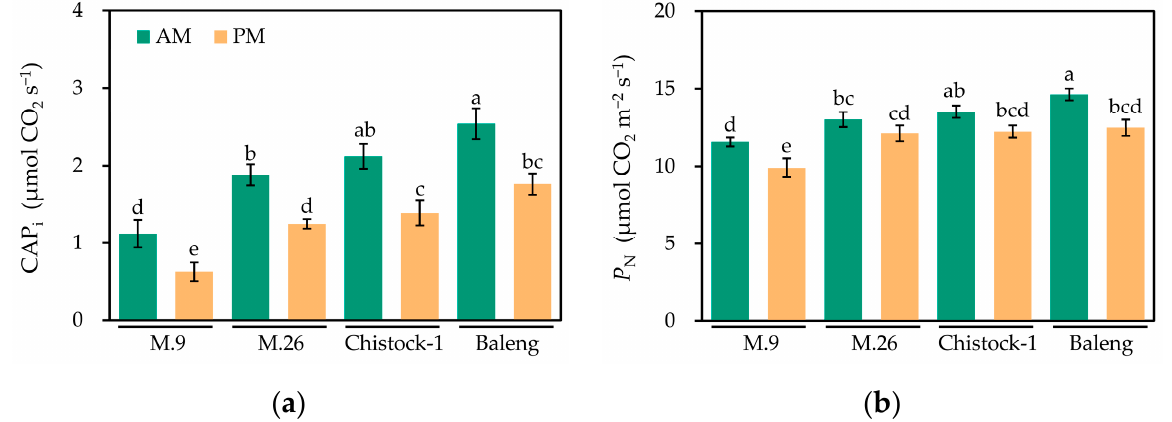
Figure 5. Instantaneous photosynthesis parameters of ‘Red Fuji’ scion leaf influenced by rootstocks in the morning (AM) and afternoon (PM). ( a ) Canopy-apparent photosynthesis (CAP i ); ( b ) leaf net photosynthetic rate ( P N ). Columns are means of data (at least eight replications) ± standard error (SE) bars. Different letters after mean values ± standard error in the same column indicate the significant difference determined by the least significant difference (LSD) test with p < 0.05.